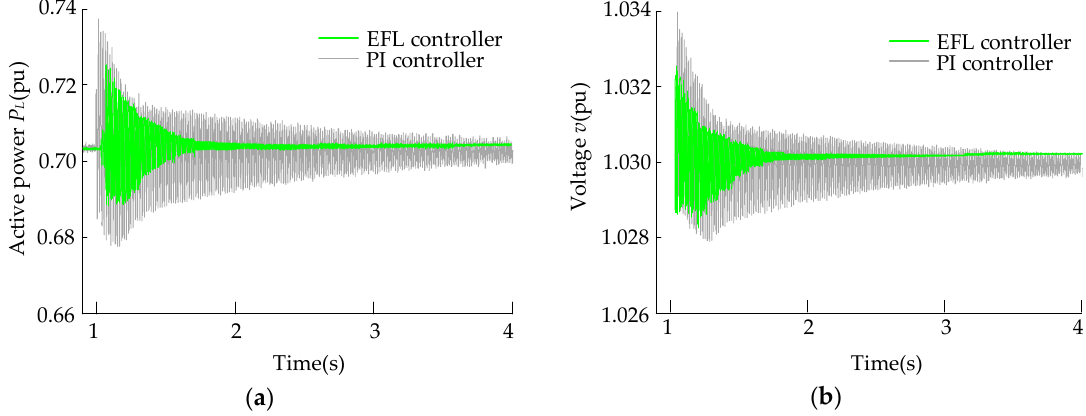
Figure 8. System responses at a wind speed of 8 m/s and a series-compensation of 40%. ( a ) Transmission line active power; ( b ) PCC voltage.